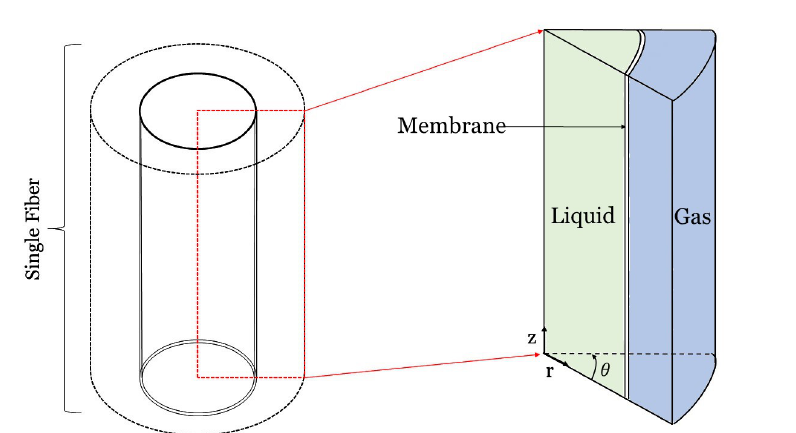
Figure 9. Graphic of the three-dimensional modeling framework for a gas-liquid HFMC. Axial (z), radial (r), and tangential ( θ ) variations are all resolved. In this graphic, solvent flows on the tube-side while flue gas flows on the